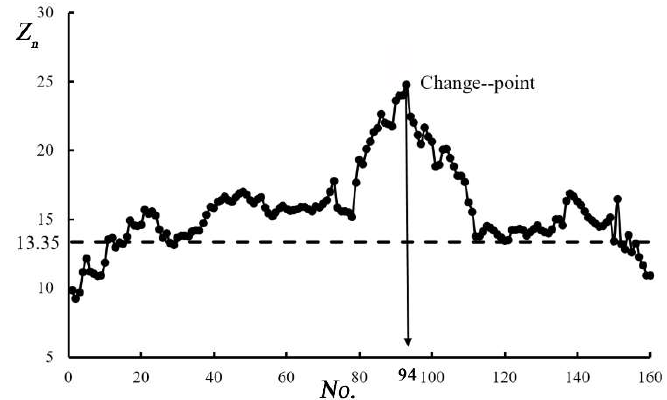
Figure 4. Analysis of the joint change-points of the combination of (Q, NH 4+ , COD Mn ).